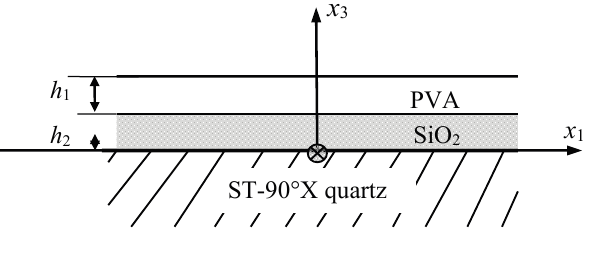
Figure 1. Schematic of the considered Love wave device and coordinate